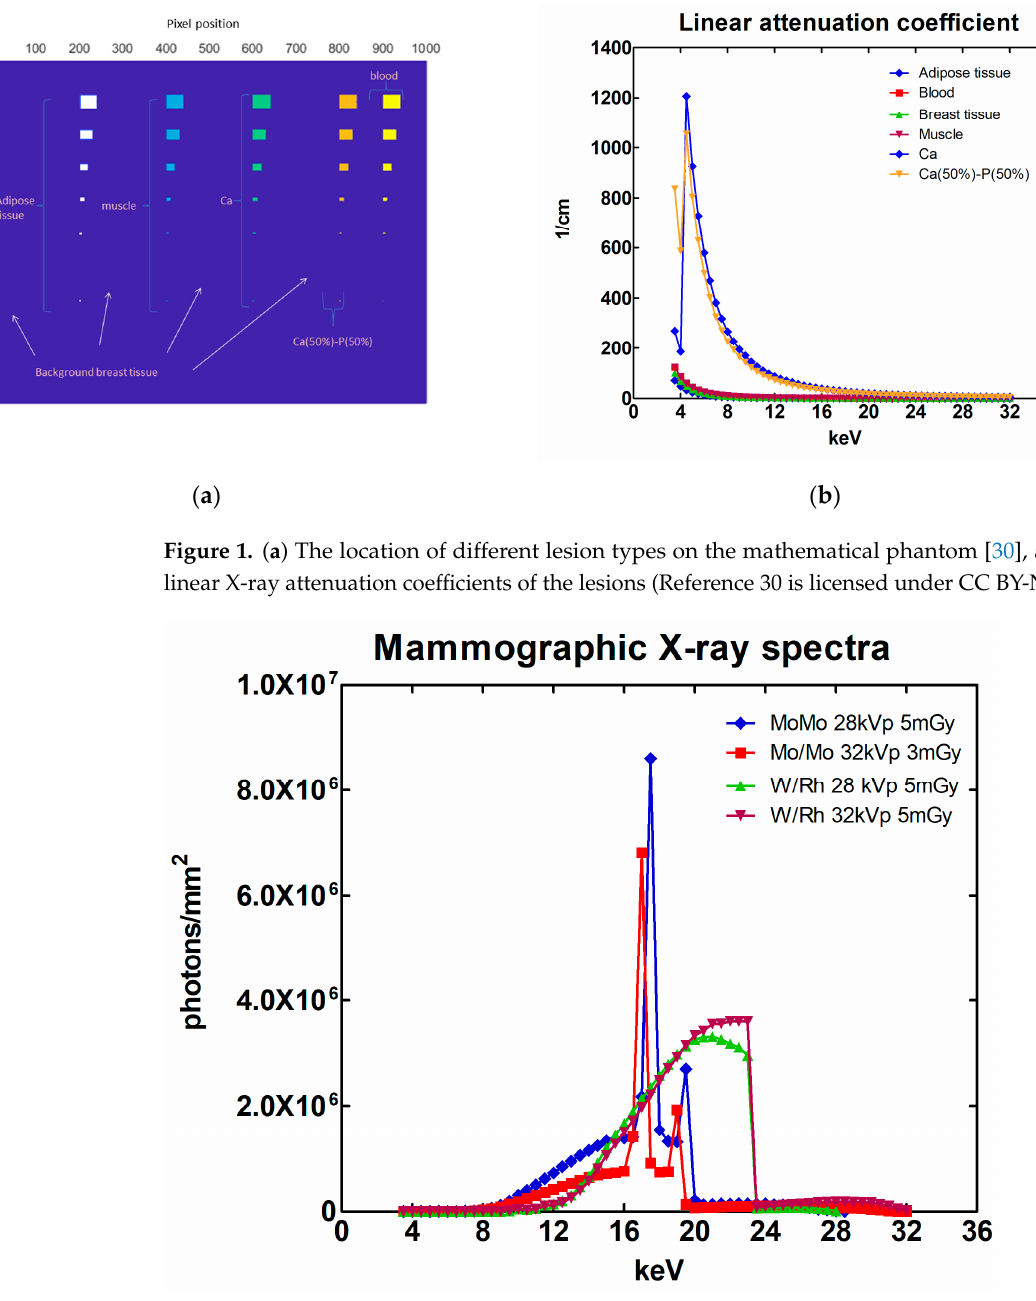
Figure 2. The mammographic X-ray spectra considered in this study.